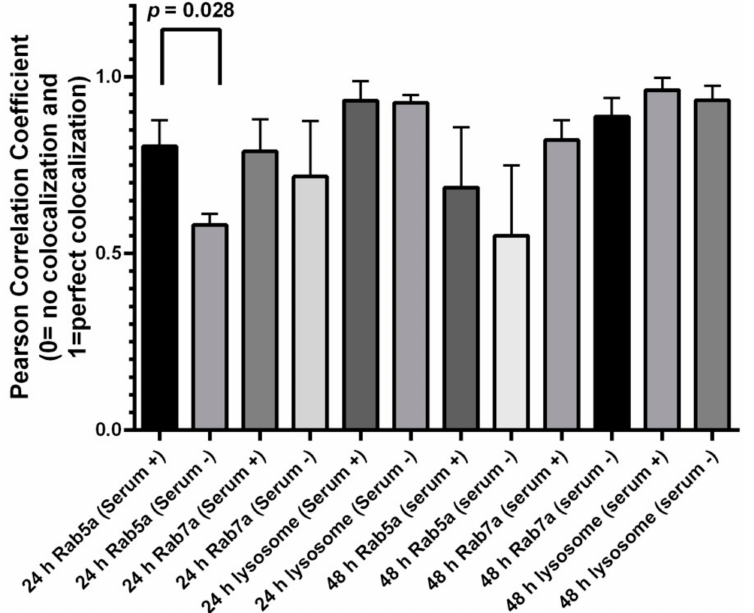
Figure 8. Colocalization assay depicting the level of colocalization between CdSe/ZnS QD and fluorescence organelle markers in HeLa cell culture. Graph bars represent the results of colocalization analysis using the JACoP plugin from ImageJ using Pearson’s correlation coefficient. Mean Pearson coefficient and standard deviation values for levels of colocalization between QDs and fluorescent organelle markers are indicated in the graph. The mean Pearson coefficient value for the level of colocalization between QDs and the early endosome in the culture with serum was statistically significantly higher than that for cells grown in the culture lacking serum ( p = 0.028, via Prism GraphPad Dunnett